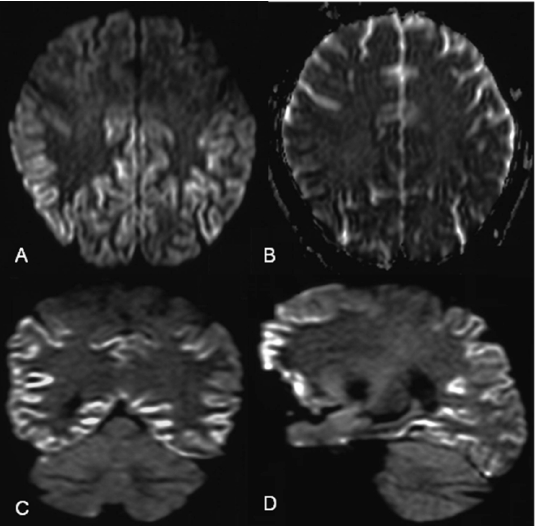
Fig. 1. A. Axial DWI shows a ribbon-like hyperintensity along the cortical gyri; B. ADC map shows correspondent low signal in the same location, consistent with restricted diffusivity of water molecules; Coronal DWI (C) and Sagital DWI (D) further demon- strate the aforementioned hyperintense gyriform lesions, involving temporal, parietal, frontal and occipital